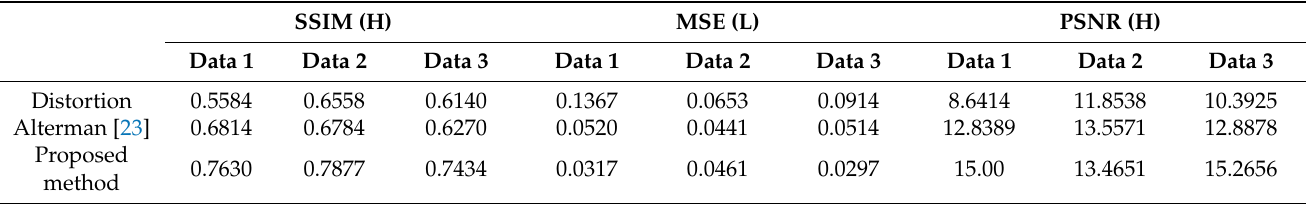
Table 2. Comparison of image quality metrics among the proposed method, the distorted image and Alterman’s method